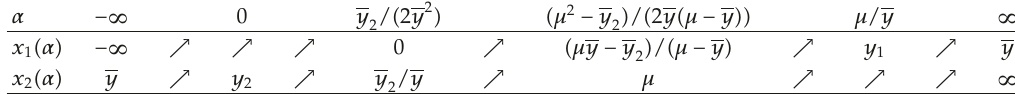
Table 1: The behavior of x 1 (cid:2) α (cid:3) and x 2 (cid:2) α (cid:3) .